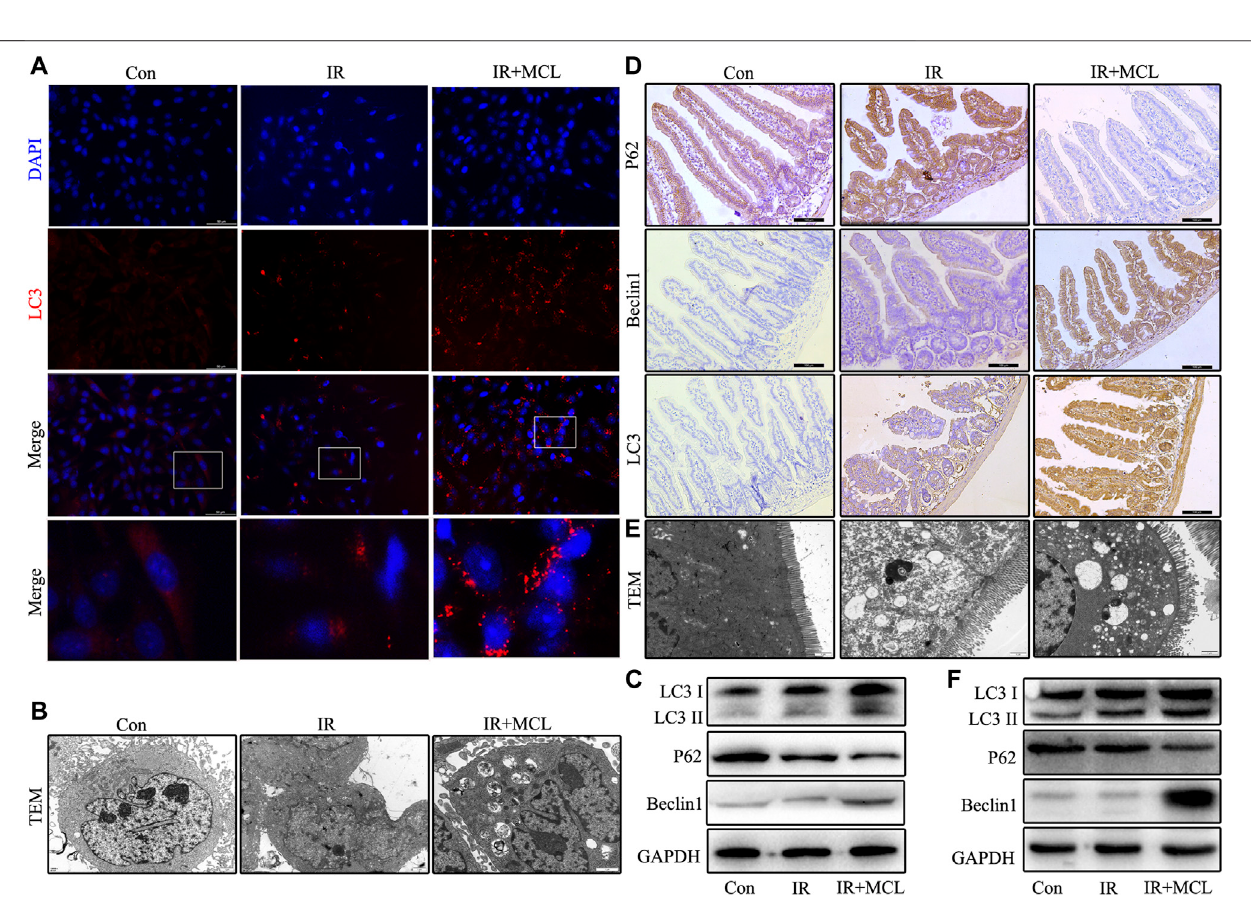
FIGURE 5 | MCL enhances autophagy in mice intestinal tissue and HIEC after radiotherapy. Con, untreated HIECs; IR, HIECs that were treated with irradiation (10 Gy); MCL + IR, HIECs pre-treated with MCL (10 μ M) prior to irradiation (A) Representative immuno fl uorescence image of LC3 aggregation in HIECs (B) Autophagosomes(arrows)inHIECdetectedbytransmissionelectronmicroscopy (C) Westernblotofp62,beclin1,andLC3proteinexpressioninHIEC.Con,untreated WT mice; IR, WT mice that were treated with irradiation (10 Gy); MCL + IR, WT mice pre-treated with MCL (50 mg/kg) prior to irradiation (10 Gy) (D) Immunohistochemical staining of p62, beclin 1, and LC3B in small intestine tissues (E) Autophagosomes (arrows) in small intestine tissue detected by transmission electronmicroscopy (F) Westernblotofp62,beclin1,andLC3proteinexpressioninsmallintestinetissues.* p < 0.05,** p < 0.01,*** p < 0.001,**** p < 0.0001,two-tailed Student ’ s t-test. IR, irradiation; HIEC, human intestinal epithelial cell; MCL, micheliolide.